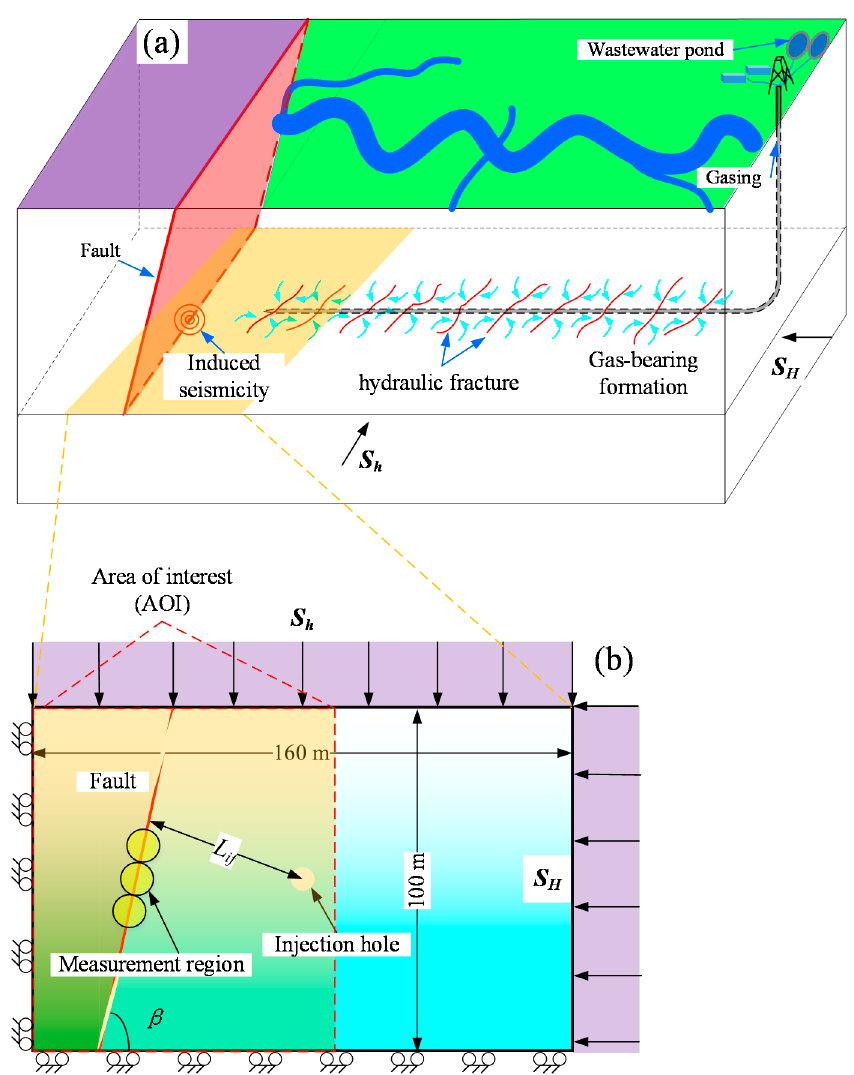
Figure 8. Geometry reservoir model for hydraulic fracturing simulation: ( a ) sketch map of simulation model; ( b ) measurement region setup.